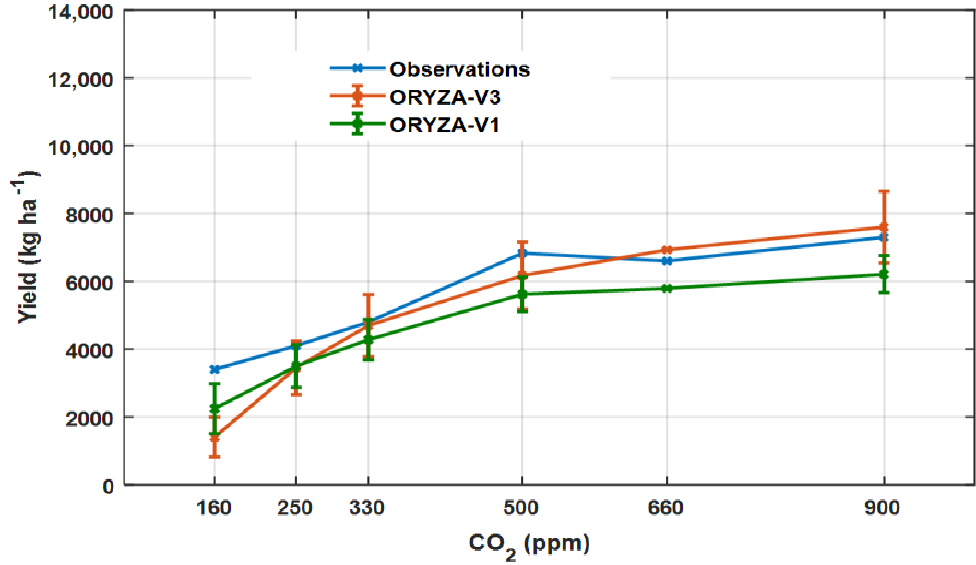
Figure 2. Comparison of observed (from [52]) and simulated rice yield for ORYZA-V1 and ORYZA- V3 under varying CO 2 concentration at constant day/night temperature of 31 ◦ C averaged over two planting dates for the IR30